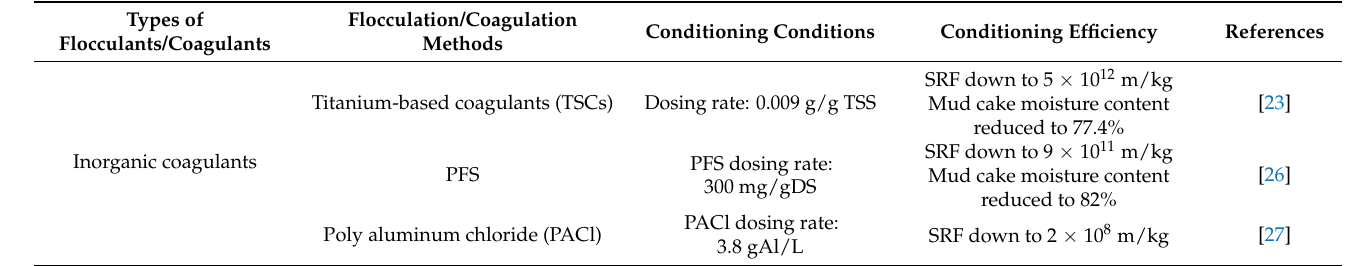
Table 3. Efficiency of different types of flocculants/coagulants for sludge